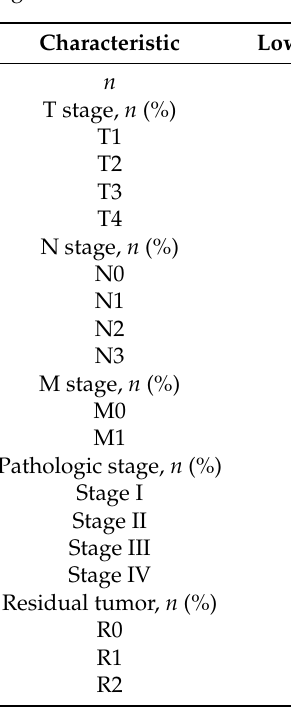
Table 2. The relationship between FUT2 mRNA expression and clinical parameters of patients with lung